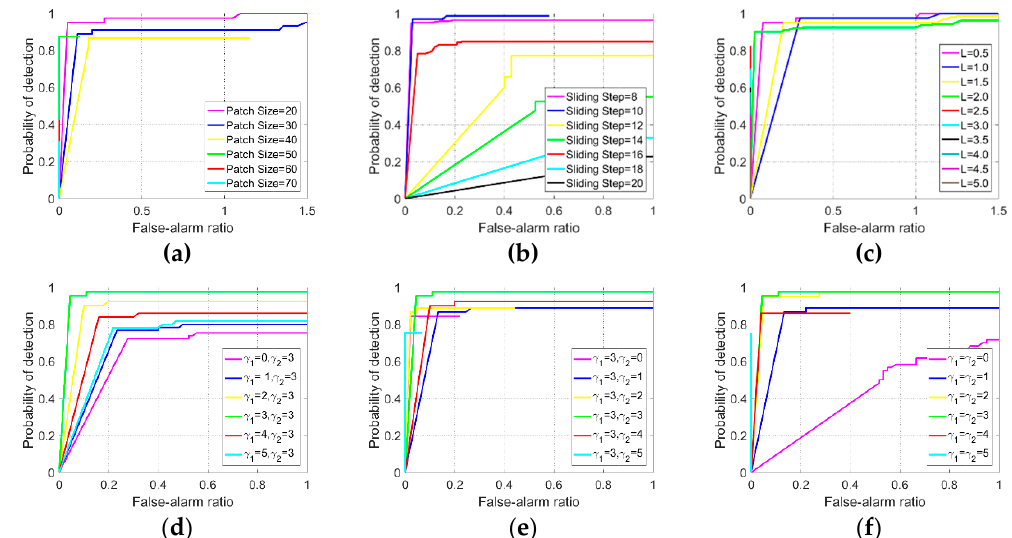
Figure 6. Receiver operating characteristic (ROC) results obtained by changing the parameters in the proposed model for the constructed test dataset. ( a ) Varying patch size. ( b ) Varying sliding step. ( c ) Varying sparse penalty. ( d ) Varying γ 1 while fixing γ 2 . ( e ) Varying γ 2 while fixing γ 1 . ( f ) Varying γ 1 and γ 2 while keeping γ 1 = γ 2